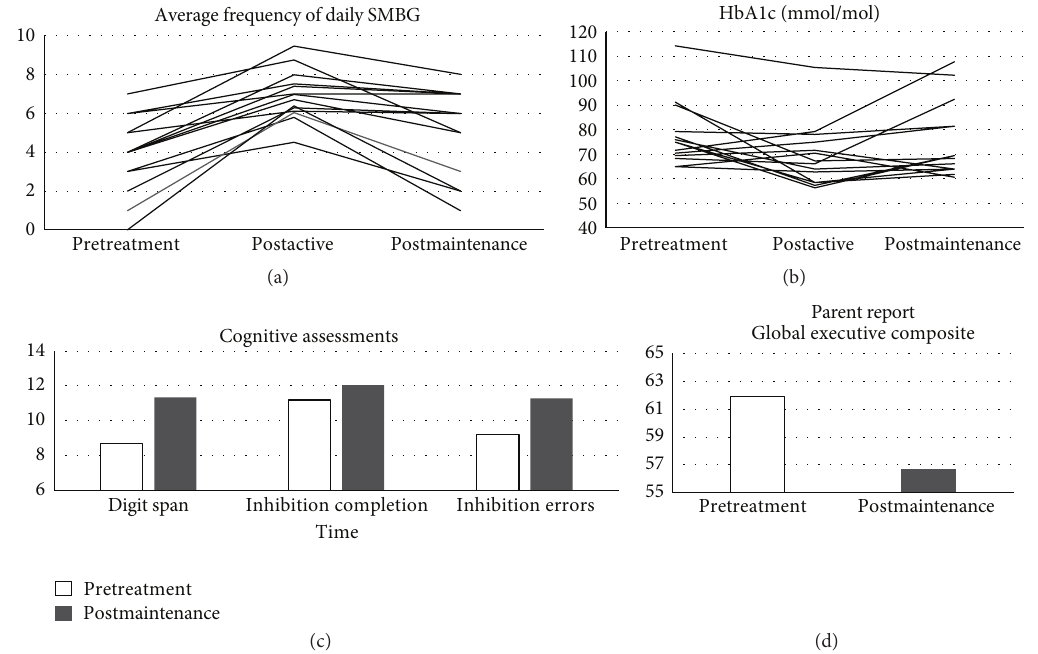
Figure 1: Individual participants’ frequency of self-monitoring of blood glucose (SMBG (a)), glycosylated hemoglobin levels (HbA1c (b)) and average scores for all participants on cognitive functioning assessment and scaled scores (c) and 𝑇 -scores (d).